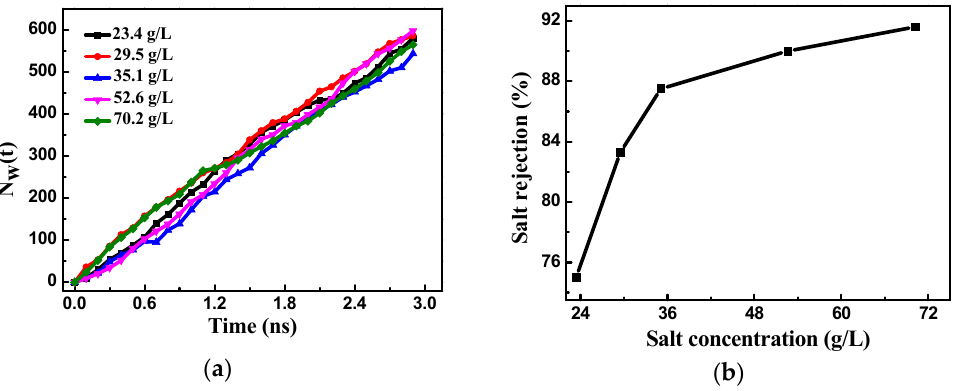
Figure 2. ( a ) The number of water molecules passing through the bilayer porous graphene membranes over time for different salt concentrations; ( b ) effect of salt concentration on the salt rejection of the bilayer porous graphene membranes.